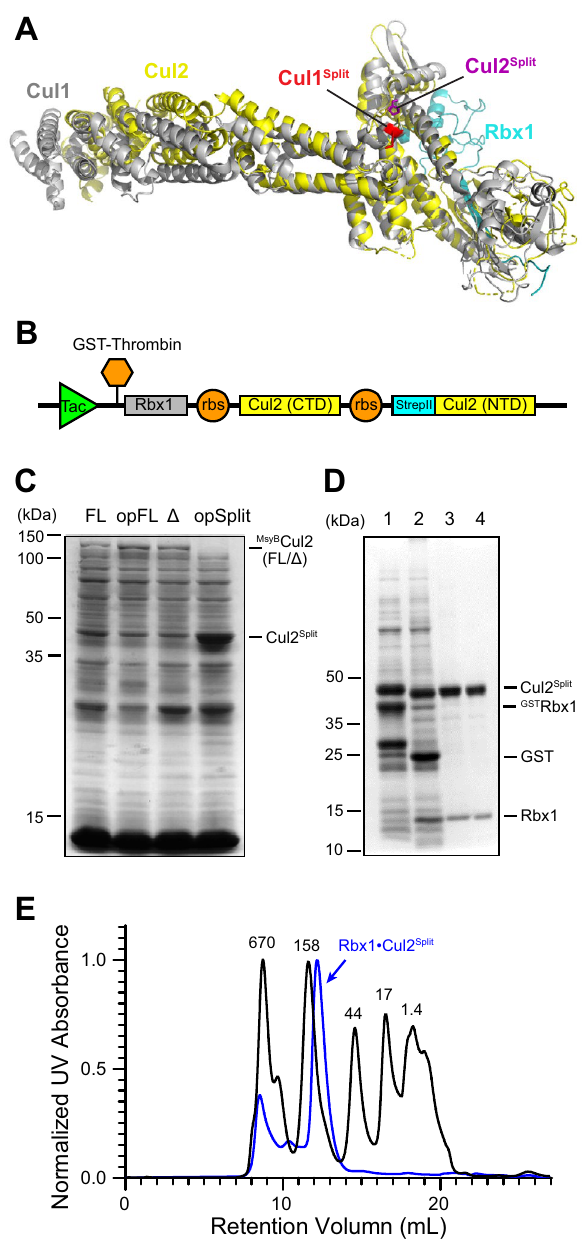
Figure 2. “Split-n-Coexpress” of RBX1•CUL2 in E. coli cells. ( A ) Structural alignment of CUL1 (PDB ID: 1U6G) and CUL2 (PDB ID: 5N4W). Splitting sites used for “Split-n-Coexpress” strategies are marked on both proteins. Grey: CUL1; yellow: CUL2; cyan: RBX1; purple: splitting site on CUL1; red: splitting site on CUL2 for expression trial. ( B ) Schematic illustrating the strategy for expressing the RBX1• StrepII CUL2 Split via “Split- n-Coexpress”. The construct contains coding sequences of GST RBX1 and the two halves of CUL2 (CTD, NTD) that are linked by ribosomal binding sites (RBS) and is driven by a Tac promoter. Tags and fusion proteins can be cleaved by the thrombin protease. ( C ) Comparison among different methods for expressing RBX1•CUL2 in E. coli cells. Excess amount of Strep-Tactin resin was used to extract StrepII CUL2 expressed via